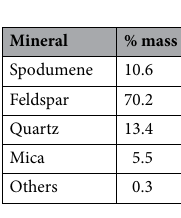
Table 1. Mineralogy of the spodumene ore.